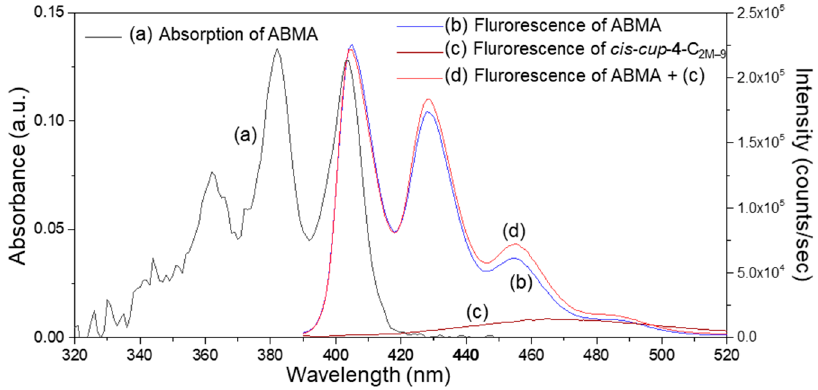
Figure 6. (a) UV-vis spectra of α , α ’-(anthracene-9,10-diyl)bis(methylmalonic acid) (ABMA) and fluorescence (FL) emission spectrum of (b) ABMA, (c) cis - cup -tris[(DPAF-C 2M )-C 60 ( > DPAF-C 9 )] ( cis - cup - 4 -C 2M–9 ), and (c) a combination of ABMA and cis - cup - 4 -C 2M–9 in a solvent mixture of DMF–CHCl 3 (1:9, v / v ) in a concentration of 10 − 6